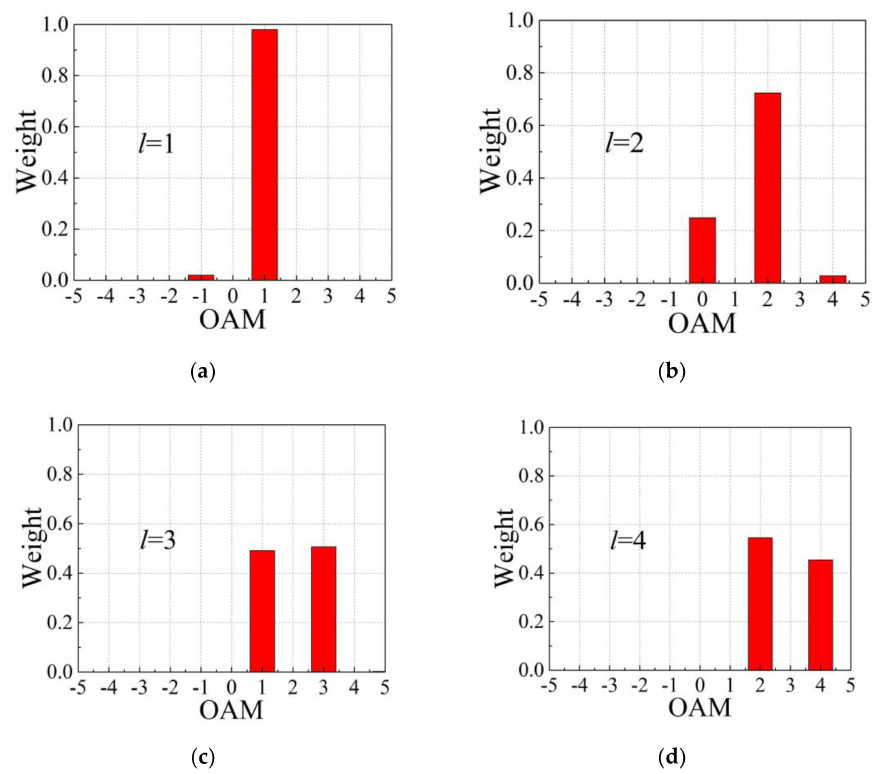
Figure 7. Weights of the OAM modes of the scattered field on the whole measurement plane: panels ( a – d ) correspond with the cases that the topological charges are 1–4, where the beam is incident. The scatterer is a uniform and isotropic spherical particle, and the measurement plane is located at z = 50 µ m.